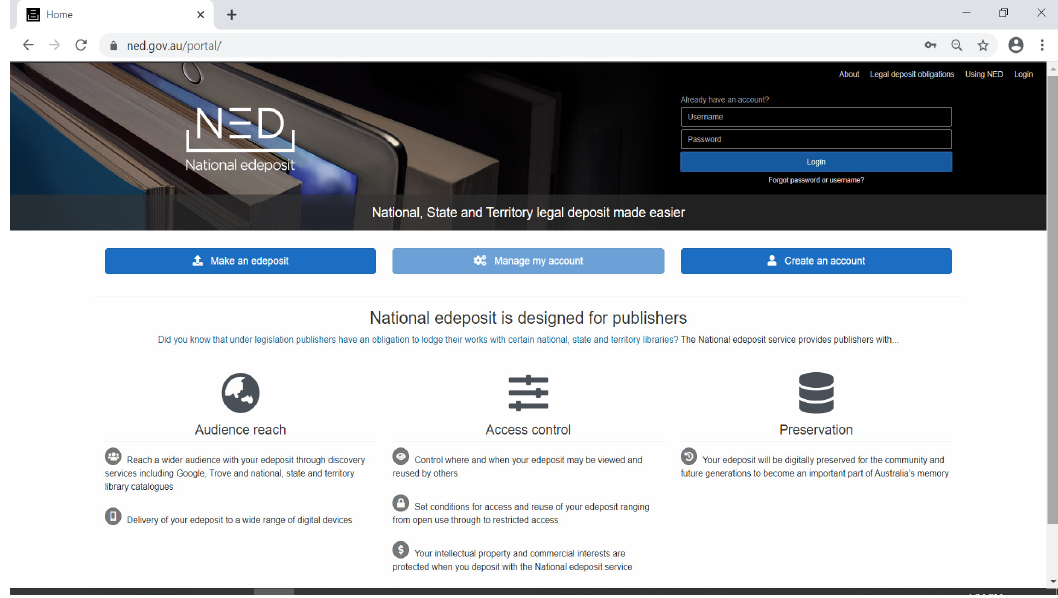
Figure 1. Home page of national edeposit service (NED) website and portal, ned.gov.au